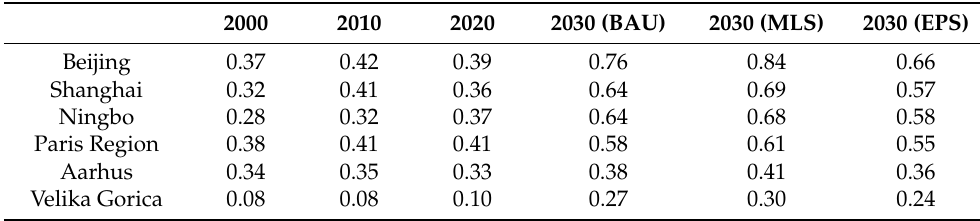
Table 3. GINI coefficients of GIF distribution for different scenarios from 2000 to 2030 for six urban long-term development